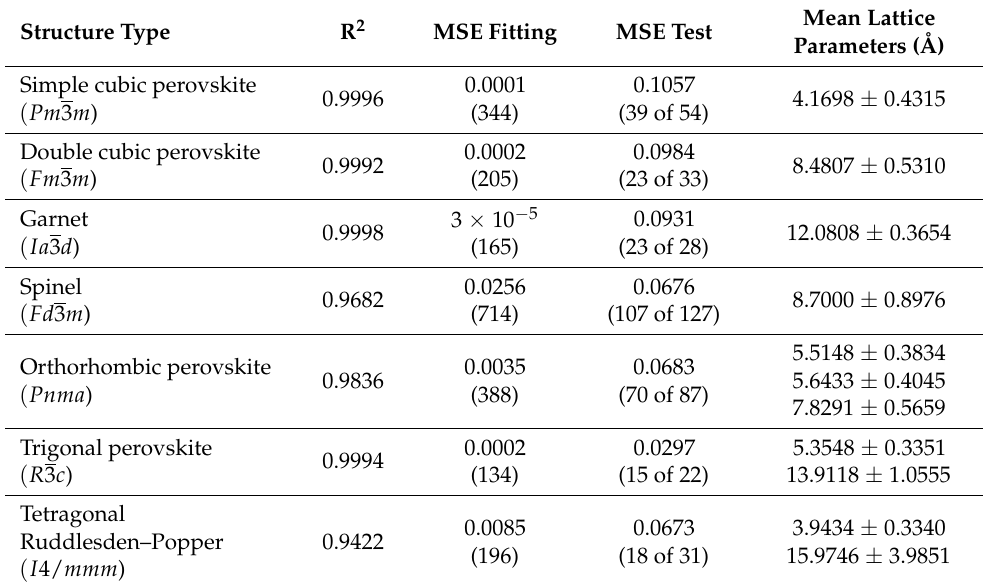
Table 4. Results of the linear regression of the lattice parameters with the extracted features in the second layer of the 6S10O-WEF